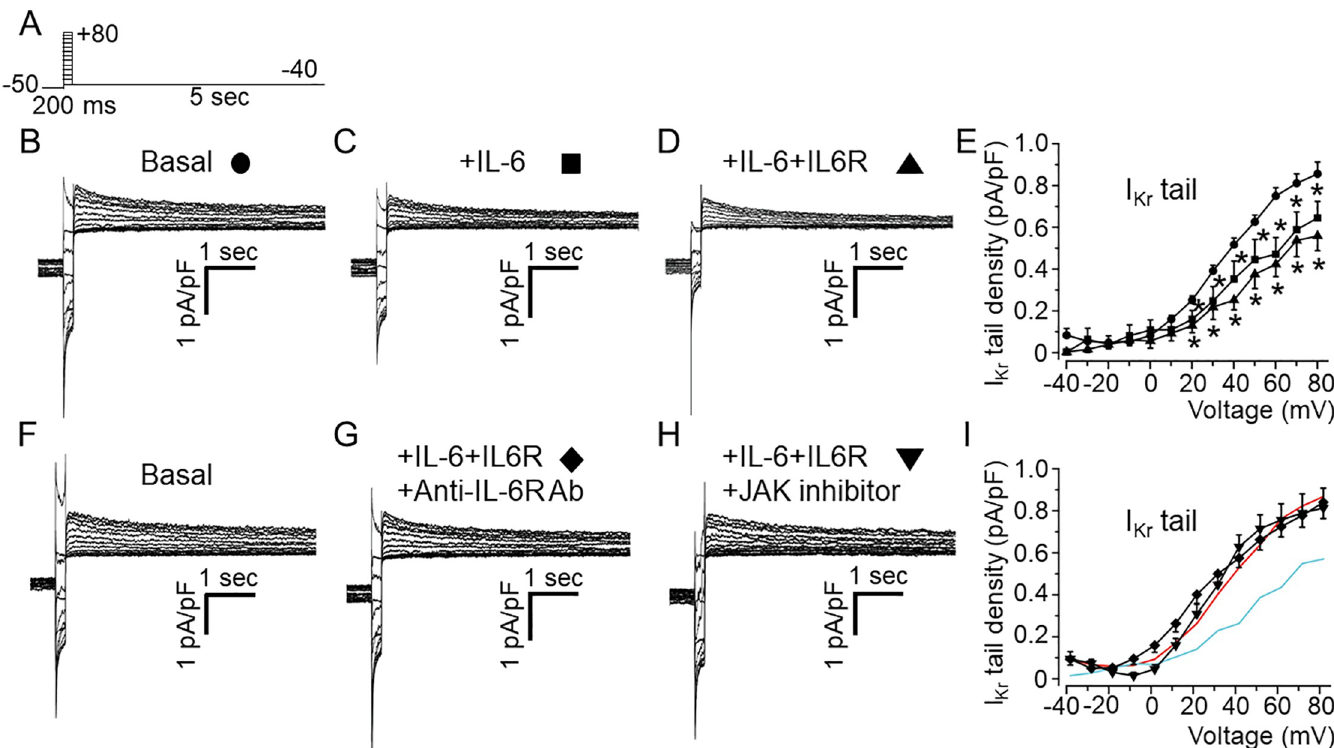
Fig 5. Effects of IL-6 and IL-6+IL-6R on I Kr in adult guinea-pig ventricular myocytes. A , Voltage protocol used for evoking I Kr in freshly isolated ventricular myocytes from adult guinea-pig heart. Tail current traces measured in the presence of 100 μ M chromanol 293B and 5 μ M nifedipine in control untreated cardiomyocyte ( B , circle, n = 15), and myocytes pre-treated with IL-6 alone ( C , square, n = 8) or IL-6 +IL-6R ( D , upward triangle, n = 5). E , Population I Kr tail density-voltage curves in basal, IL-6- and IL-6R-treated adult guinea-pig ventricular cardiomyocytes. F , Representative I traces in basal condition, ( G ) pre-treatment with IL-6+IL-6R in the Kr presence of anti-IL-6R antibody (Ab) at 100 μ g/ml or, H ) a JAK inhibitor-I (5 μ M). I , the mean I Kr tail density-voltage curves show that the inhibitory effect of IL-6+IL- 6R on I is reversed in the presence of anti-IL-6R antibody (diamond, n = 12) or JAK inhibitor I (downward triangle, n = 5). For visual comparison, data for control I Kr Kr ( Red trace ) and in the presence of IL-6+IL-6R ( Cyan trace ) in I .